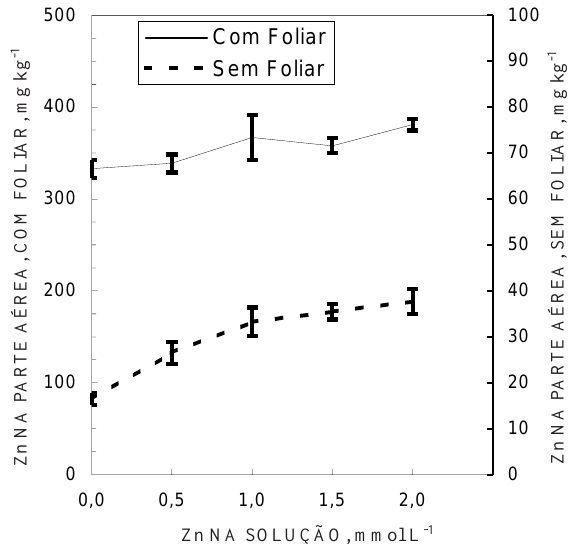
Figura 2. Teores de zinco na parte aérea de plantas de milho, considerando a concentração do nutriente na solução nutritiva e a aplicação de zinco via foliar. As barras verticais mostram o desvio-padrão dos